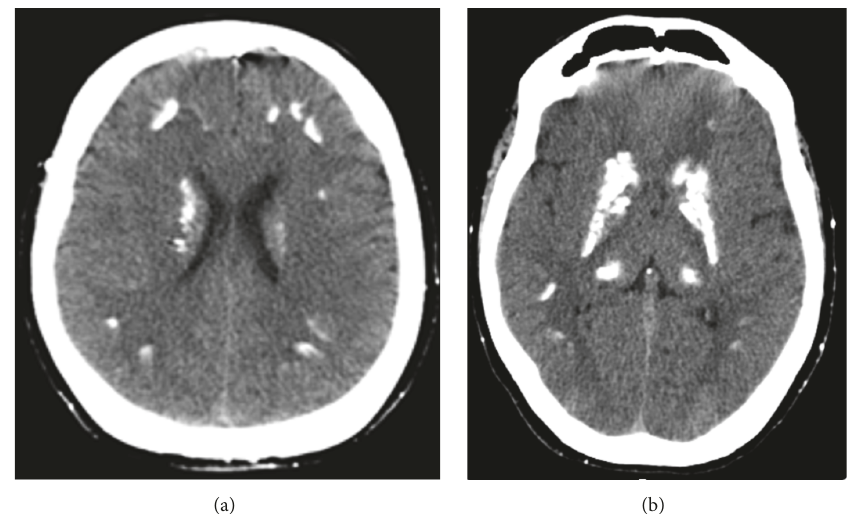
Figure 2: Axial cuts of CT scan, revealing diffuse subcortical frontoparietal (a) and striatum capsularis and thalamus calcifications (b).